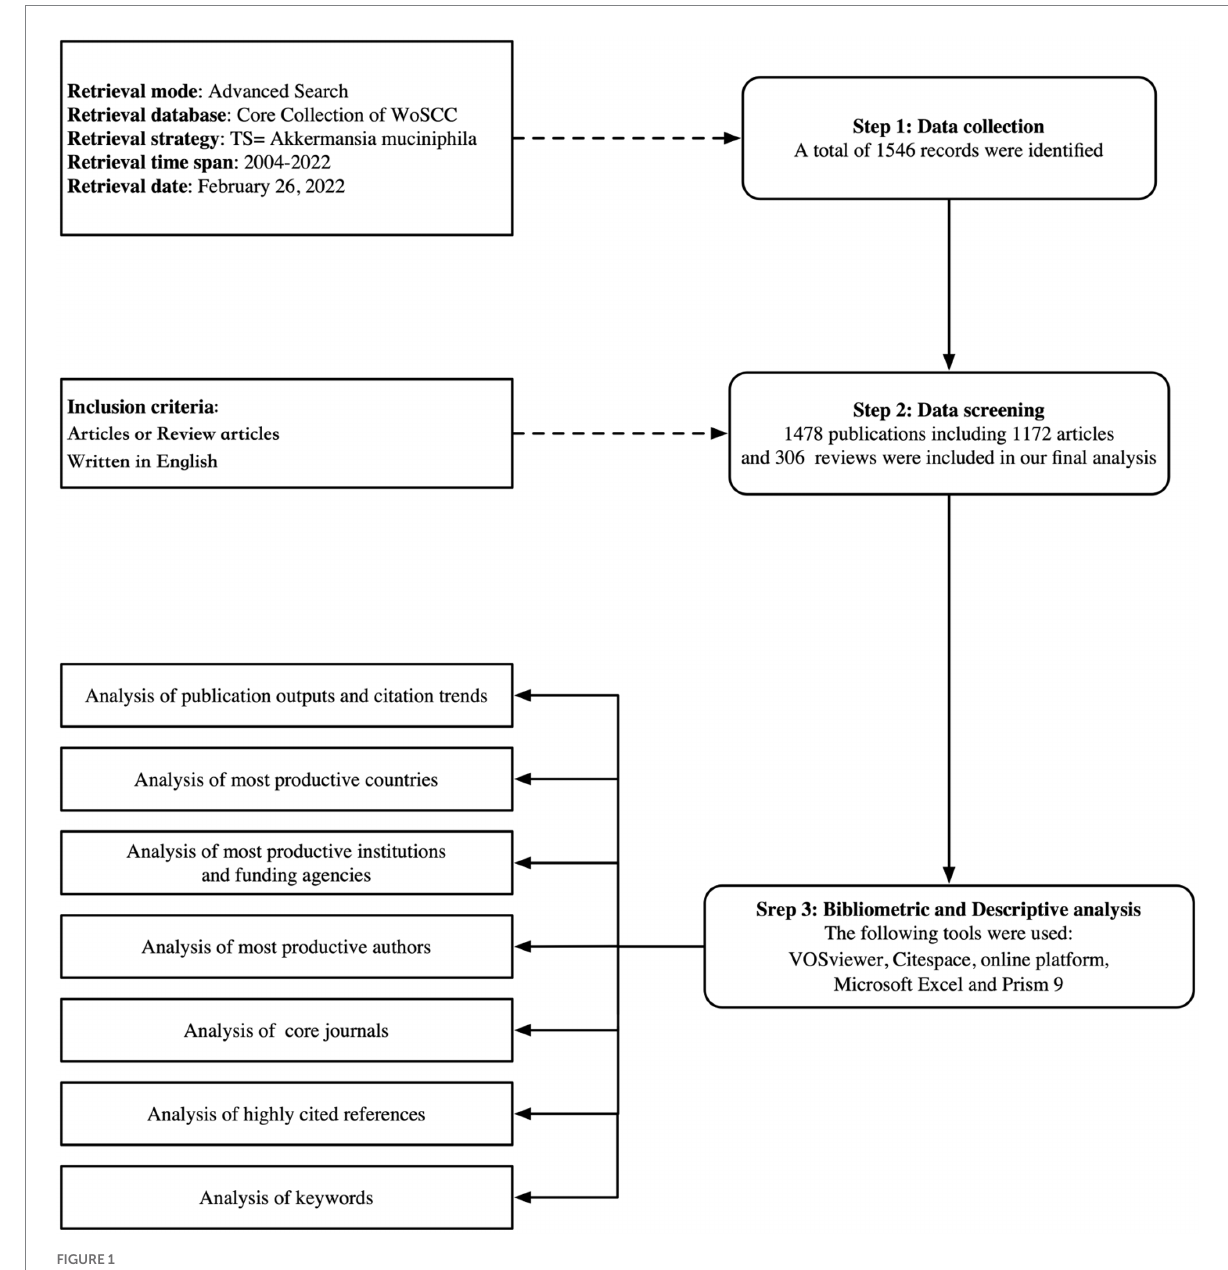
FIGURE 1 Flowchart of literature filtering and data